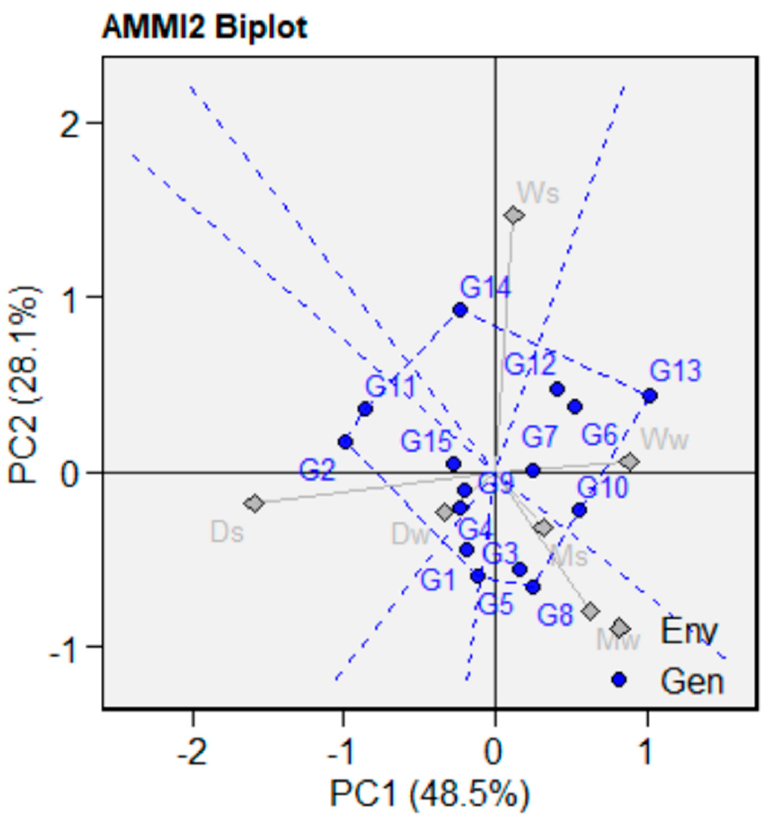
Figure 2. Potential mega-environments groupings and performance of maize genotypes in southern Mozambique by polygon method: Ds = Poorly watered in summer; Dw = Poorly watered in winter; Ms = Moderately watered in summer; Mw = Moderately watered in winter; Ws = Well-watered in summer; Ww = Well-watered in winter.